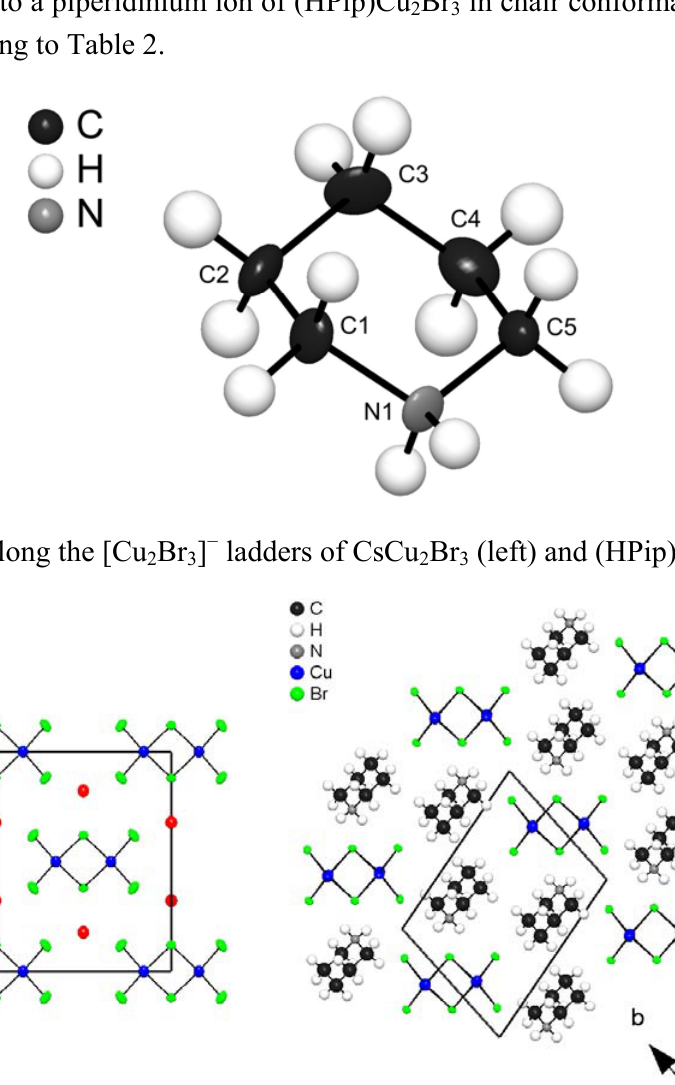
Br in chair conformation. The atoms 2 3